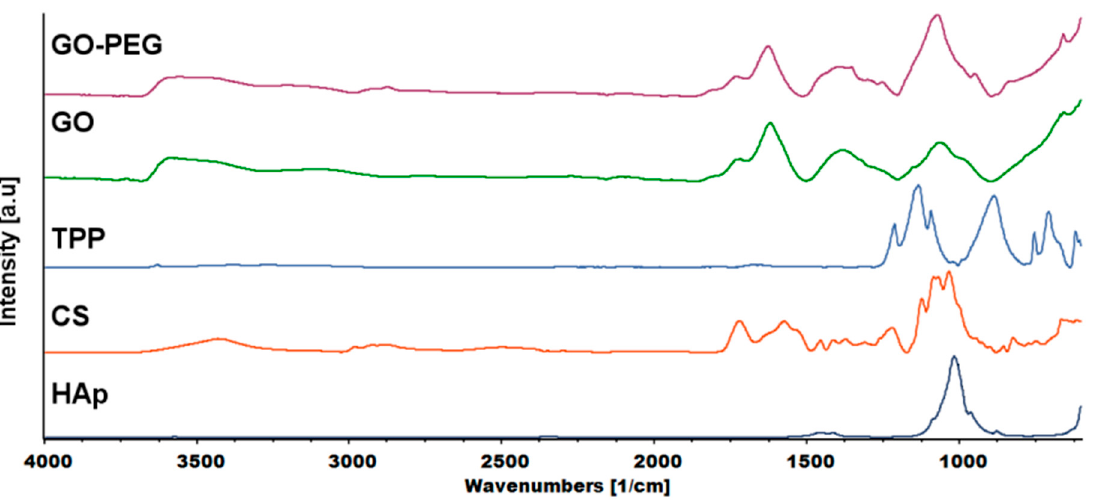
Figure 8. FTIR (Fourier transform infrared spectroscopy) spectra of the hydrogels components: HAp—hydroxyapatite, CS—chitosan, TPP—sodium tripolyphosphate, GO—graphene oxide, GO-PEG poly(ethylene glycol) grafted graphene oxide). Table 1. The main characteristic peaks of the hydrogel components (TPP—sodium tripolyphosphate,